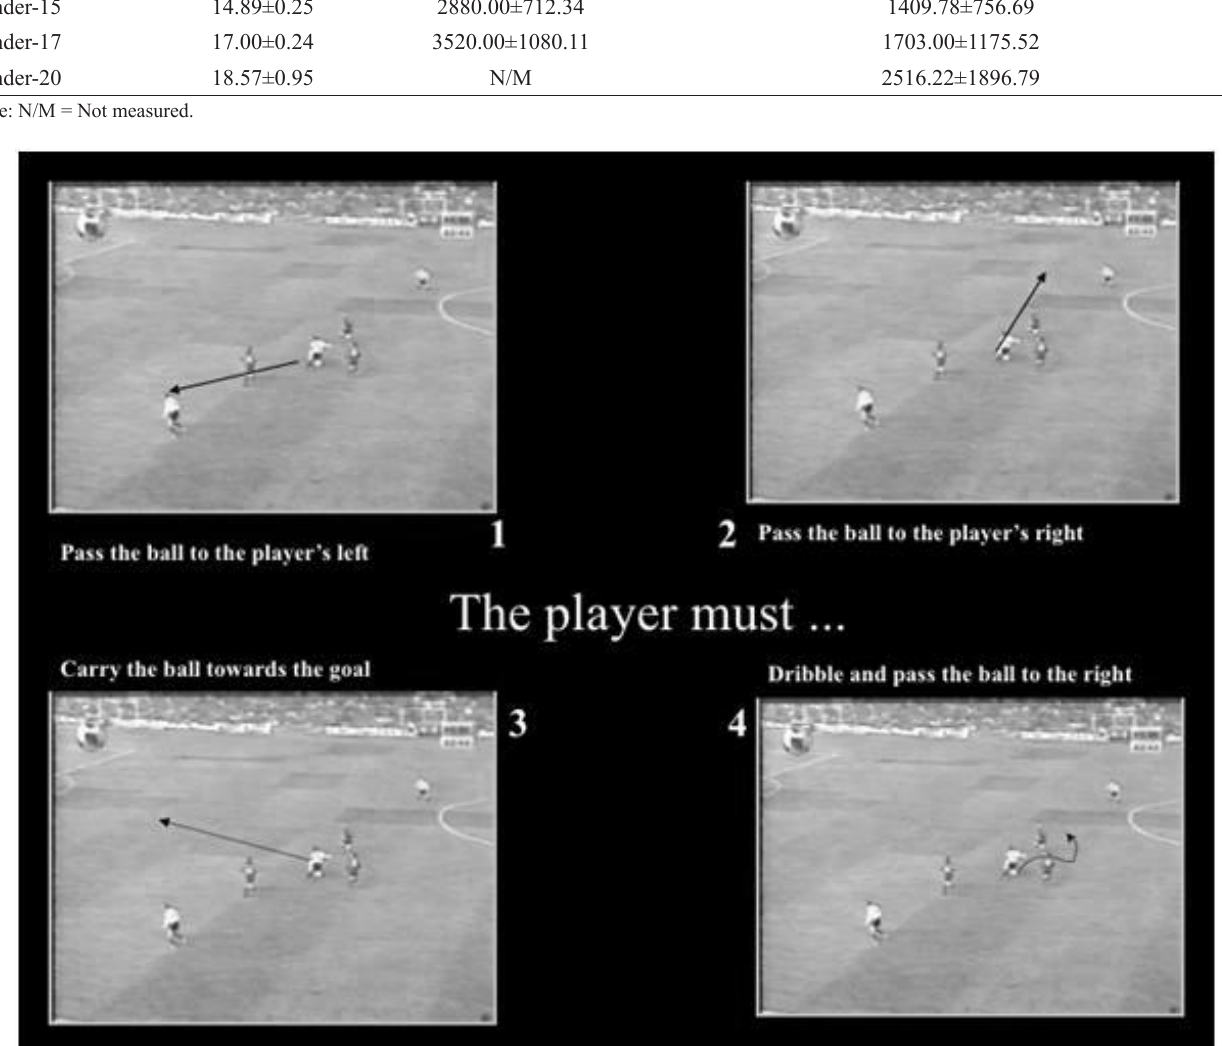
Figure 1. An example of frozen image of a video sequence (Adapted from Mangas et al., 2002). Table 2. Frequency of correct answers (C.A.) and standardized residuals (e) per statement type for each age